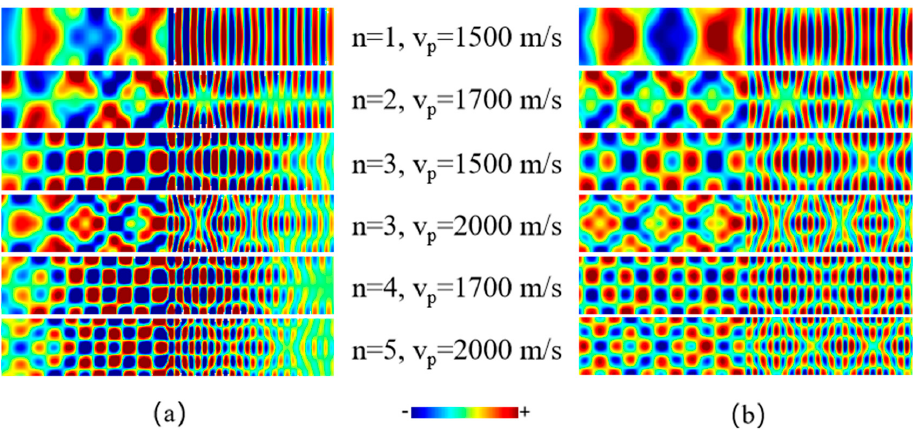
Figure 4. ( a ) SW patterns obtained in simulations which are excited by moving field pulses with different speeds. Each field pulse has a specially designed spatial distribution to couple maximally to a mode with a certain order number as indicated by n . ( b ) Wave patterns reproduced by artificially superposing several pure eigen modes with same phase velocity and different order numbers.